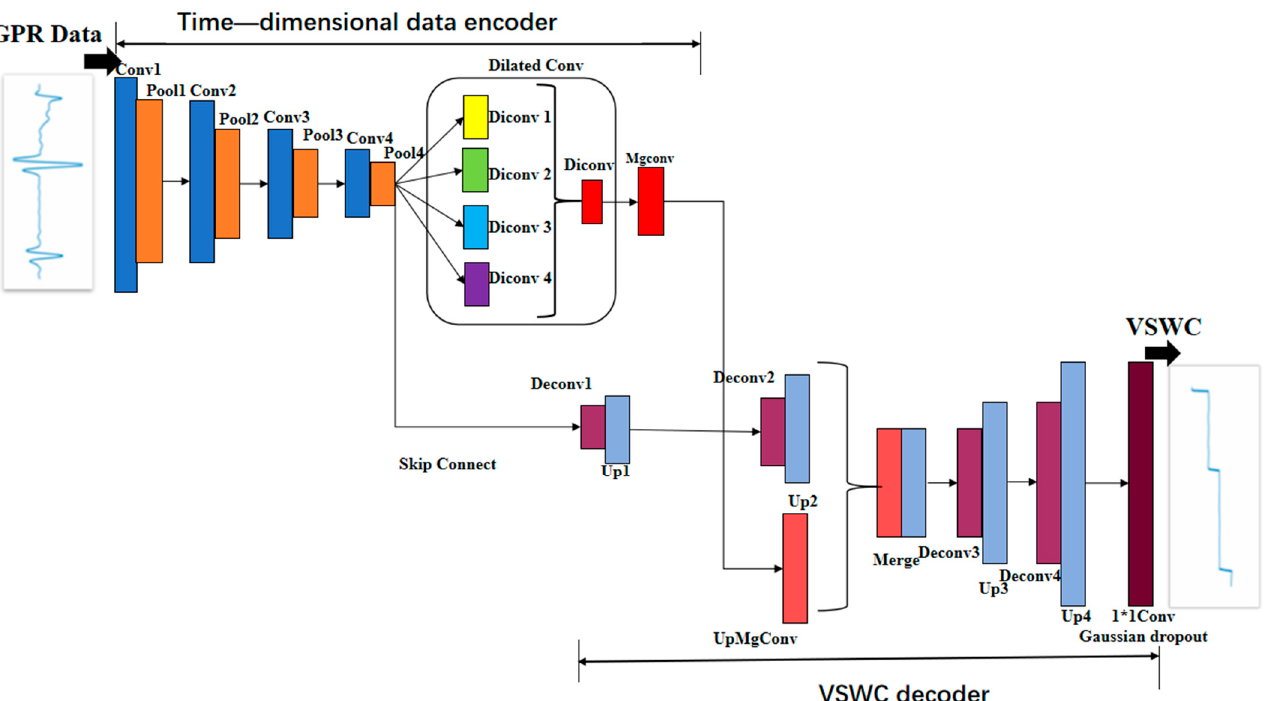
Figure 1. The structure of CNN-based framework GPRSW. The top half is the GPR data encoder, and the bottom half is the VSWC decoder. GPR data is input into the neural network, and the network outputs VSWC of the same length. Conv1–4 and Deconv1–4 are convolutional layers; Pool1–4 are pooling layers; Diconv1–4 are dilation layers; Up1–4 are up-sampling layers.